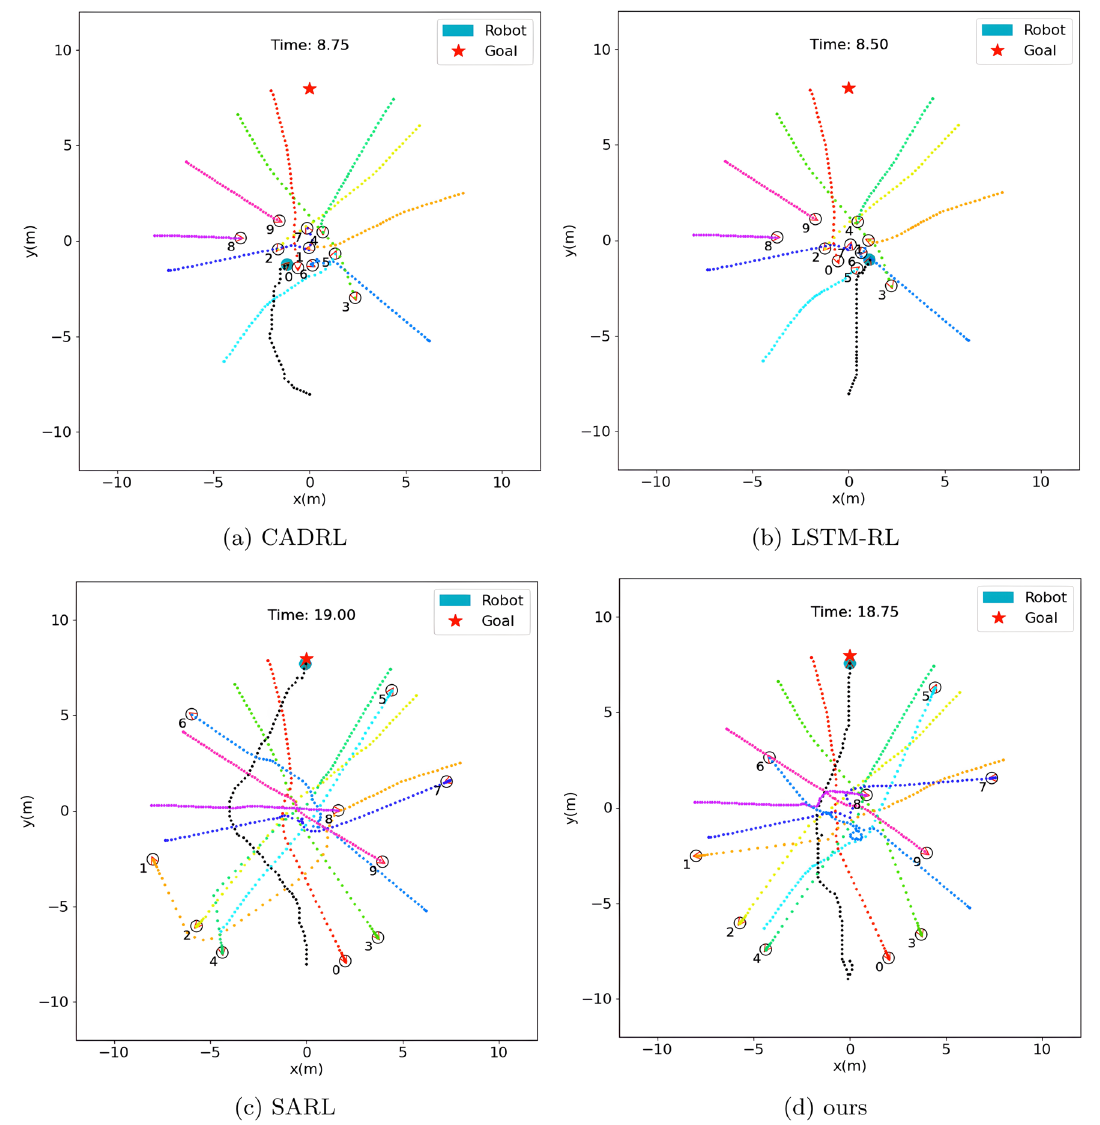
Fig. 6 Comparison of state-of-art methods of multi-agent navigation in the context of avoiding human cluster while robot